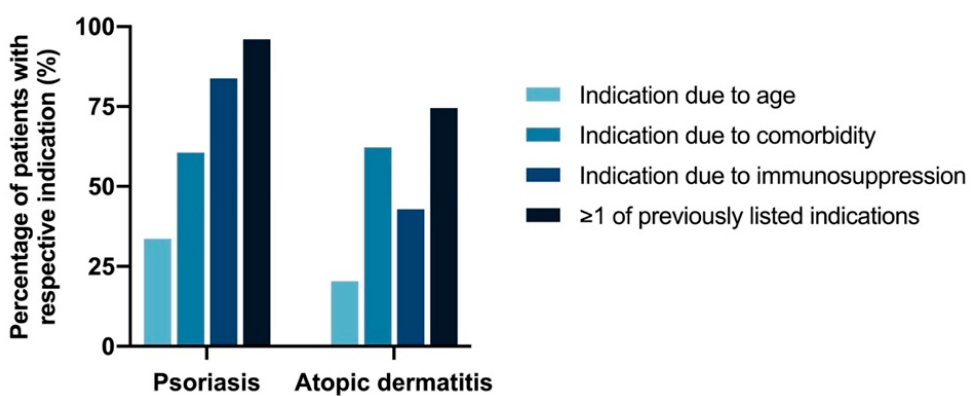
Figure 1. Percentage of patients with indication for pneumococcal vaccination. The figure shows the percentage of PsO and AD patients with respective indications for pneumococcal vaccination according to STIKO recommendation [14]. “ ≥ 1 of previously listed indications” depicts all patients that have at least one indication for pneumococcal vaccination. The vast majority of patients (PsO: 96.0% and AD: 74.5%) had at least one indication for vaccination. STIKO: permanent vaccination commission of the Robert Koch